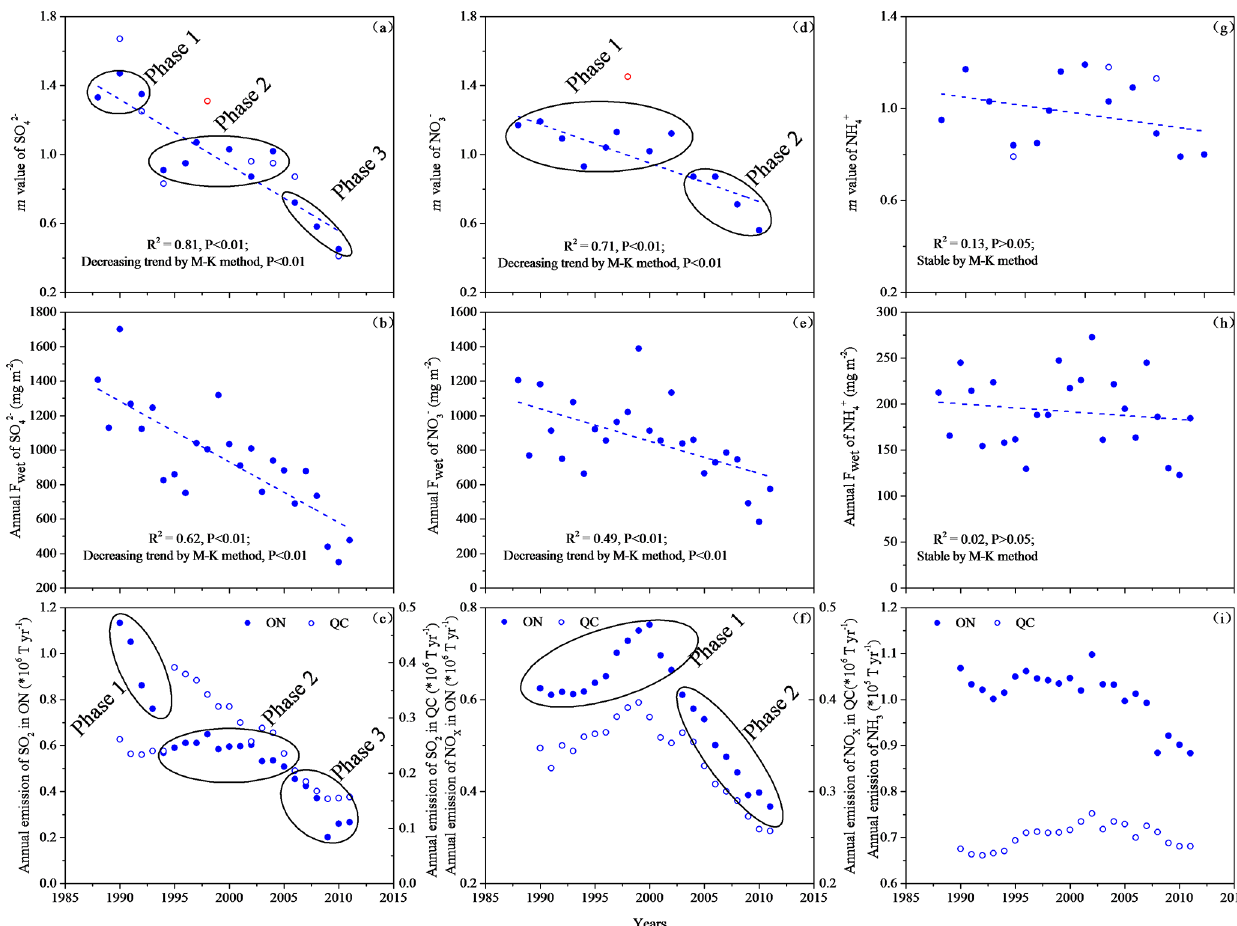
Figure 2. The m values and annual F wet of SO 2 − , NO − and NH + in 1988–2011 at Site 1, and the annual emissions of SO 2 and NO x in 4 3 4 1990–2011 in Quebec and Ontario, Canada. Full and empty markers in blue in (a) , (d) and (g) represent the calculation of m values without and with the outlier, respectively. Empty markers in red represent the outliers in m values and are excluded for trend analysis, as detailed in Sect. 2. R 2 reflects the coefficient of determination of a variable against the calendar year from LR analysis, and the fitted lines represent the LR function. M–K results are shown in (a–b) , (d–e) and (g–h) . Phases 1, 2 and 3 in (a) and (c) , Phases 1 and 2 in (d) and (f) were gained from PLR presented in Sect.